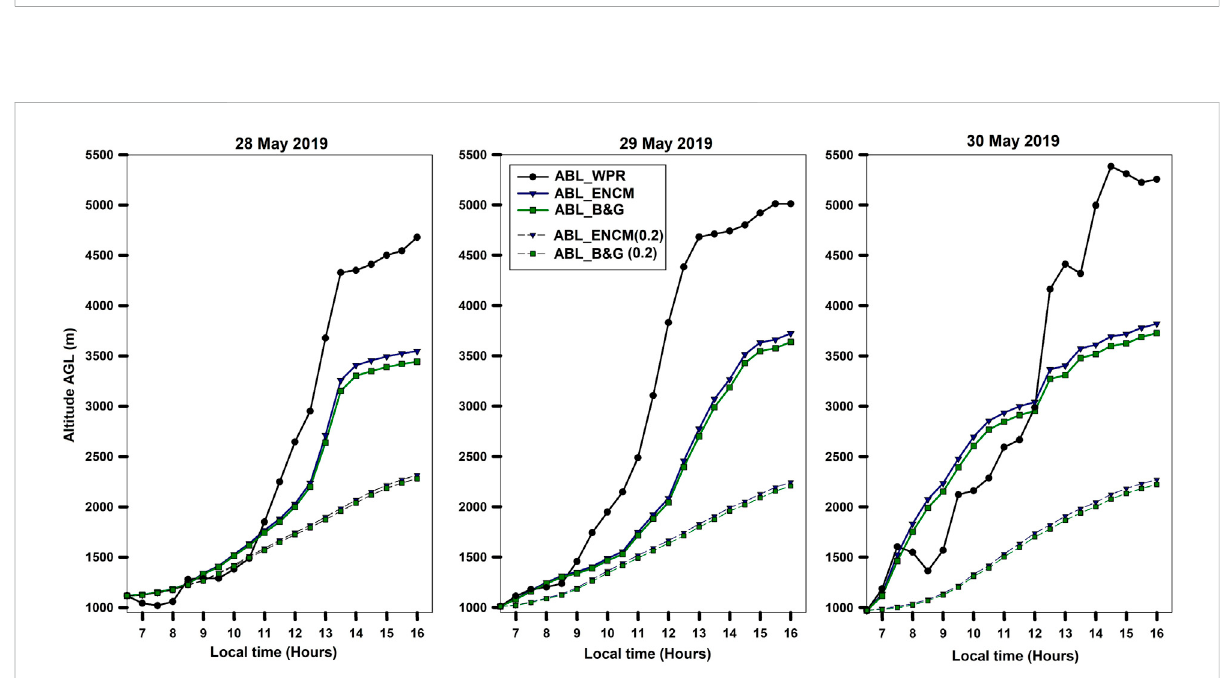
FIGURE 10 Comparison of half hourly estimates of ABL height on 28, 29, and 30 May 2019 between WPR retrieved ABL height and model estimates. The black circles represent WPR ABL retrievals; whereas the Blue triangles and Green squares represent ABL estimates based upon the Encroachment model and B&G model respectively. The blue and green dashed line (with triangle and squares) represent the model estimates of ABL evolution with constant entrainment coef fi cient of 0.2, while the blue and green solid lines (with blue triangles and green squares) are the model estimates of ABL evolution with dynamic entrainment coef fi cient based primarily upon WPR vertical velocity